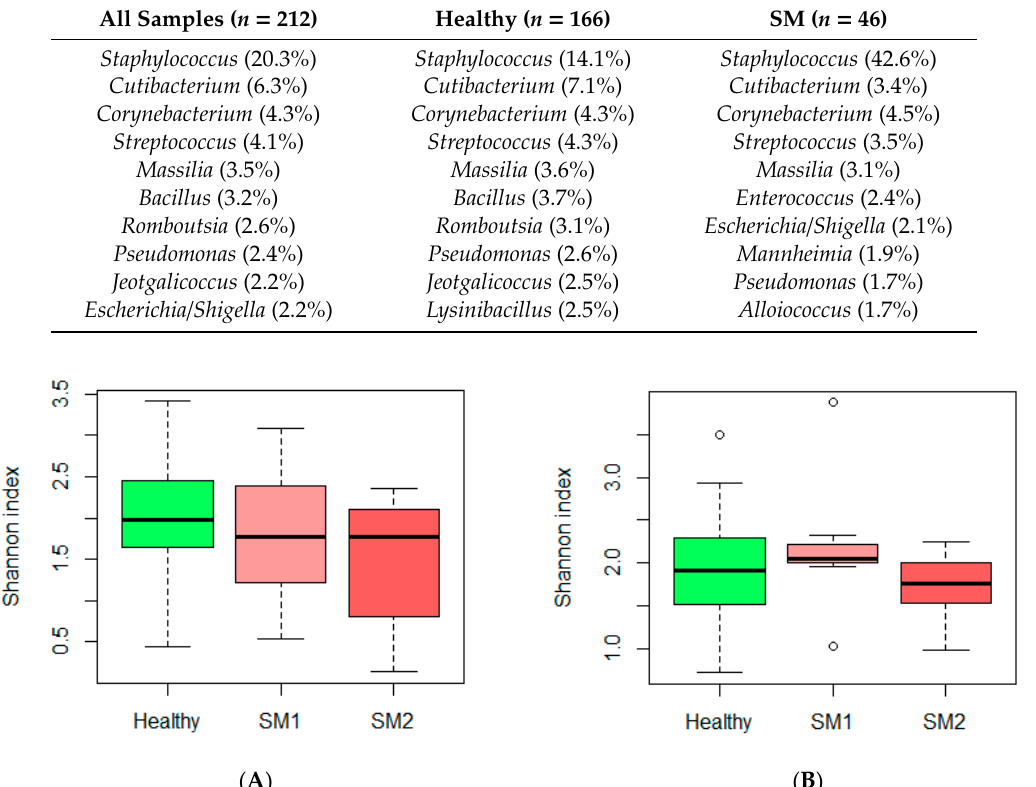
Figure 2. Boxplot graph representation of the alpha diversity Shannon index across groups of Churra milk samples defined based on somatic cell count (SCC) values. ( A ) Milk microbial diversity in Churra-Flock 1 ( A ) and Churra-Flock 2 ( B ) of Churra milk samples is represented for the three groups of samples defined in this work based on the SCC thresholds: “Healthy”, “SM1” (SCC > 400.000 cells/mL) and “SM2” (SCC > 2,000,000 cells/mL). Table 2. Relative microbial abundances for the 10 top-most abundant genera identified by the microbiota analysis of the three groups of Churra milk samples defined based on SCC.